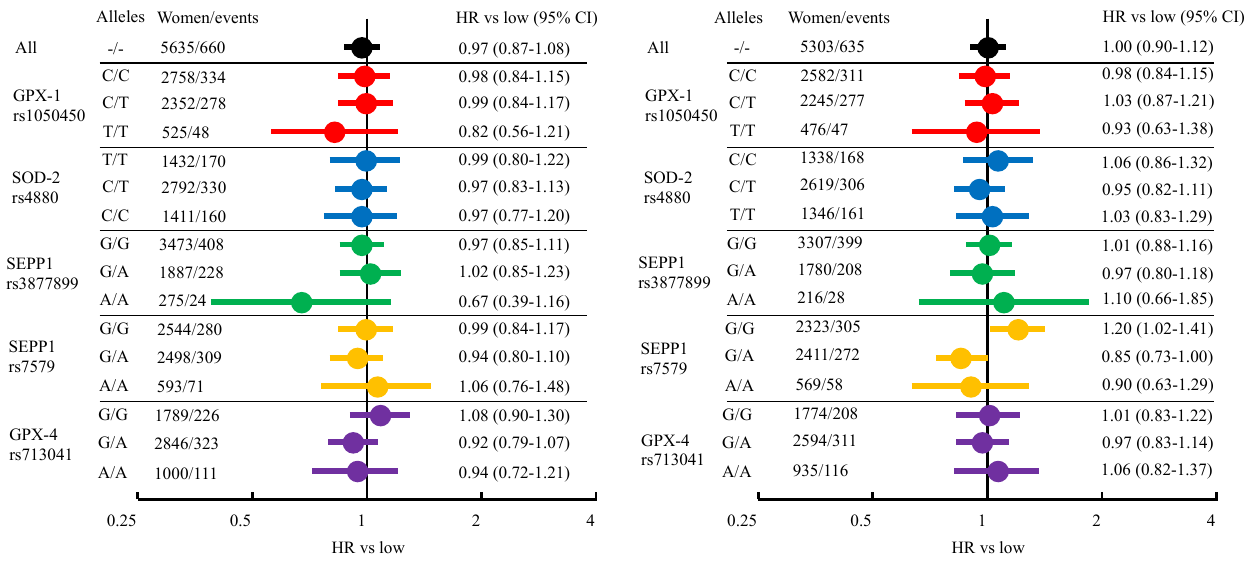
Figure 2. Forest plot of unadjusted hazard ratios (HR) for allele score tertiles and breast cancer risk. Each color represent results stratified for different SNPs. Table 2. Unadjusted hazard ratios (HR) with 95% confidence intervals (CI) for risk of breast cancer comparing breast cancer events for women with 1 or 2 effect alleles to women homozygote for reference allele of different